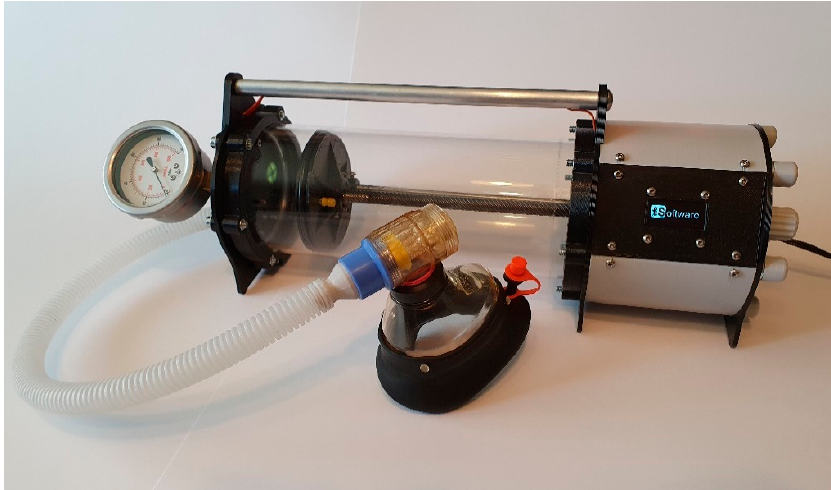
Figure 6. A photo of the finished device created with iS Rapid.